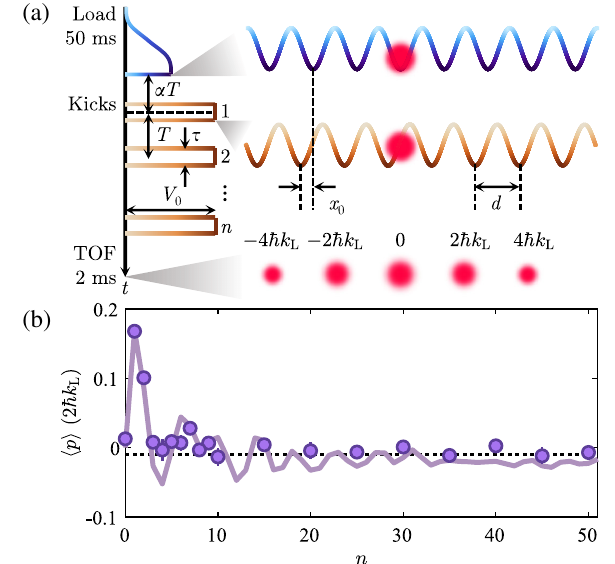
FIG. 1. Observation of the quantum boomerang effect. (a) Ex- perimental sequence. A BEC is loaded into one optical lattice and then kicked with a second, phase-shifted lattice. The momentum distribution is measured after free expansion. The BEC size and timeline are not to scale. (b) Measured average momentum versus kick number for parameters given in the text. The return to the origin demonstrates the quantum boomerang effect. Error bars show standard error of the mean on ten repeated measurements. The solid curve is the numerical prediction. The dotted line represents infinite-time average predicted by the Floquet diagonal ensemble [Eq.